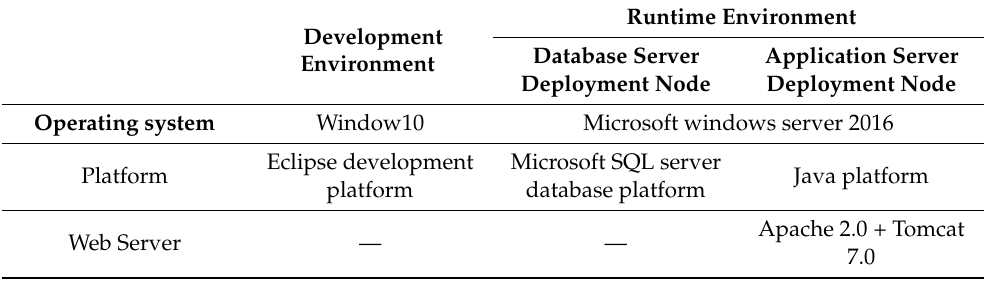
Table 1. System development and operation environment.